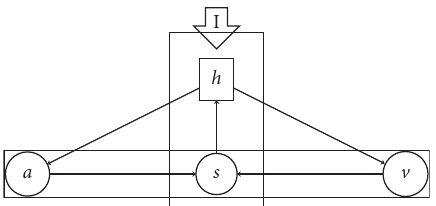
Figure 1: Schematic representation of emotional influence in our agent based model [9]. The horizontal layer describes the gener- ation of an emotional expression ( s ) dependent on the valence ( v ) and the arousal ( a ) of the agent. The vertical layer describes the generation an emotional information field ( h ) from such ex- pressions. I denotes possible external events generating emotional information. The emotional field h then influences the valence and arousal of all other agents. The formal expressions for these in- fluences are given in Section